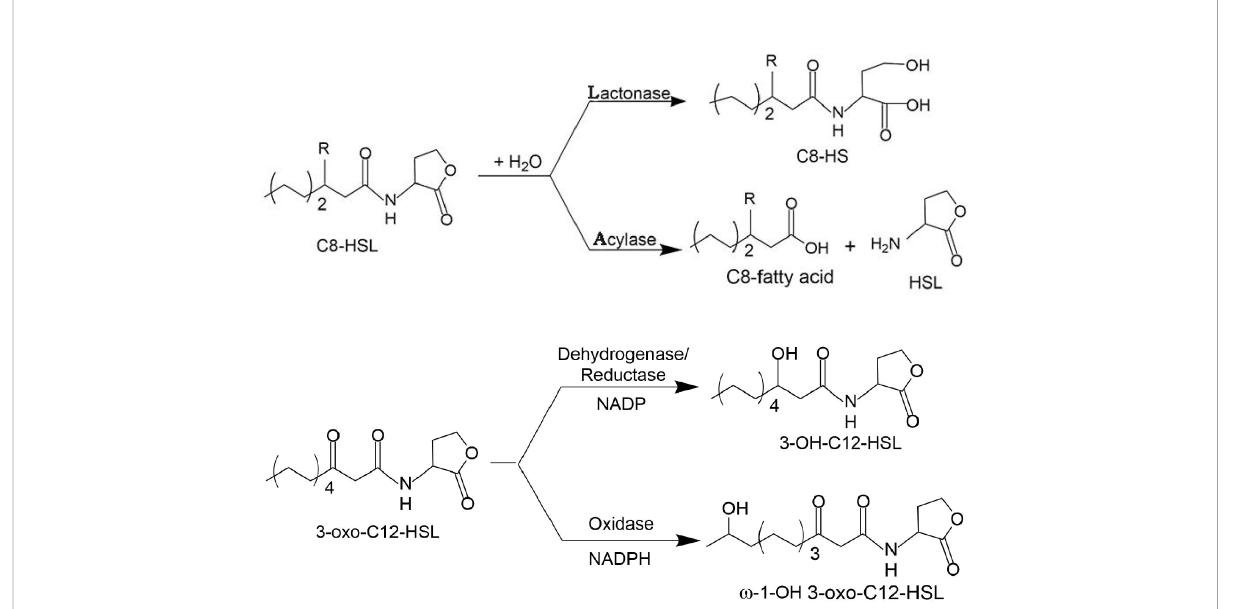
FIGURE 3 Mechanisms of AHL inactivation by lactonases, acylases, reductases, and oxidases: (1) AHL lactonases cleave homoserine lactone ring, generating acyl homoserine in reversible reaction; (2) AHL acylases catalyze the hydrolysis of AHL on amide bonds and generate fatty acid chains and homoserine lactone in an irreversible reaction; (3) NADP-dependent AHL reductases act on C3, reducing carbonyl groups to hydroxyl groups (Bijtenhoorn et al., 2011); (4) 3-Oxo-C12-HSL is oxidized at the w -1, w -2, w -3, or even w -4 and w -5 carbons by NADPH- dependent oxidase (Chowdhary et al.,